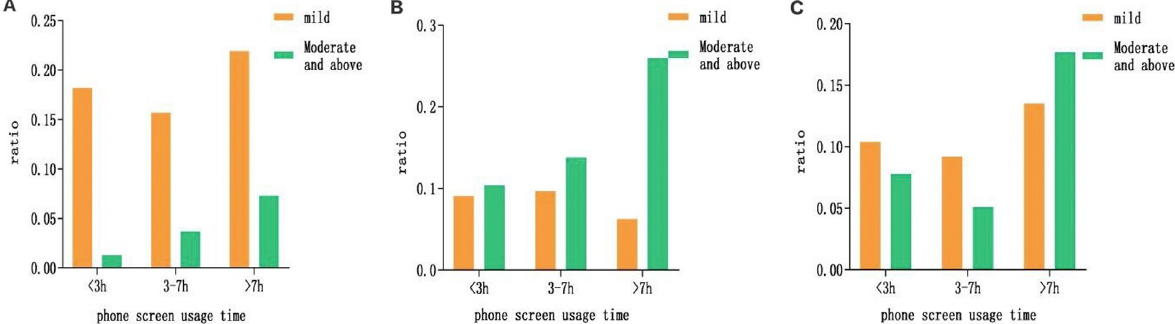
Fig 2. Comparison of the severity of negative emotions in different college students’ mobile phone screen use time. (a)Comparison of different stress severity of college students’ mobile phone screen use time; (b)Comparison of anxiety severity among college students with different mobile phone screen usage time; (c)Comparison of depression severity among college students with different mobile phone screen usage time.